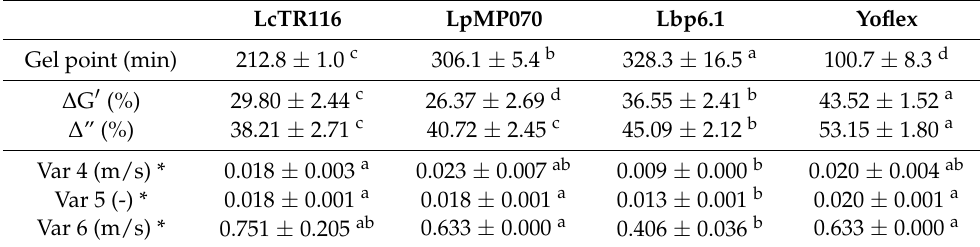
Figure 4. Storage modulus G ′ (left y -axis) and damping factor tan( δ ) (right y -axis) measured over 12 h fermentation time to monitor gel formation. Average values are displayed, error bars have been omitted for clarity. Table 4. Gel point in minutes of oscillatory analysis during fermentation; losses in storage modulus ( ∆ G (cid:48) ) and loss modulus ( ∆ G (cid:48)(cid:48) ) in percent between the end of the first oscillatory interval and the end of the second oscillatory interval of the three-interval-thixotropy test; Variables 4–6 of tribologi- cal